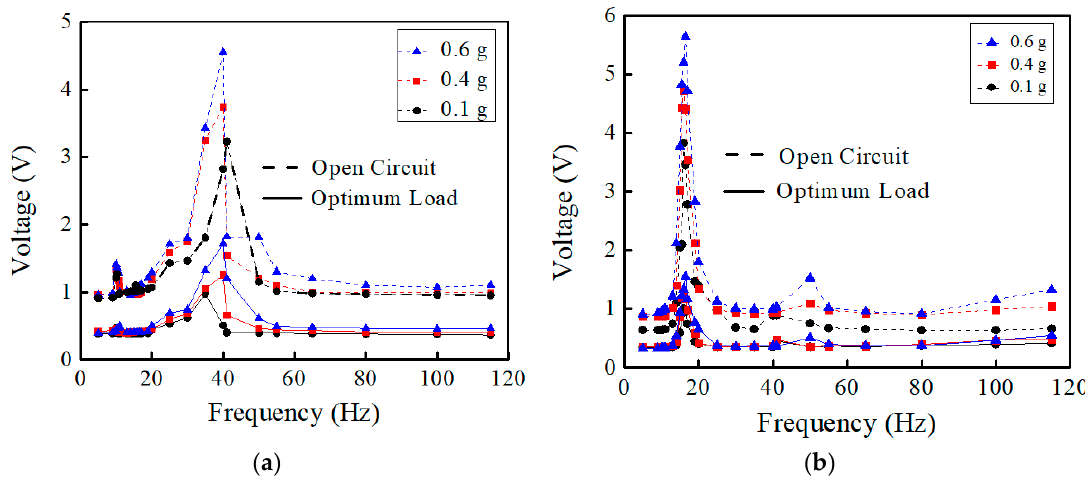
Figure 7. HIEH subjected to different acceleration levels: ( a ) Frequency response of the lower hybrid generator for no-load and optimum load resistance, ( b ) Frequency response of the upper hybrid generator across no-load and optimum load resistance.